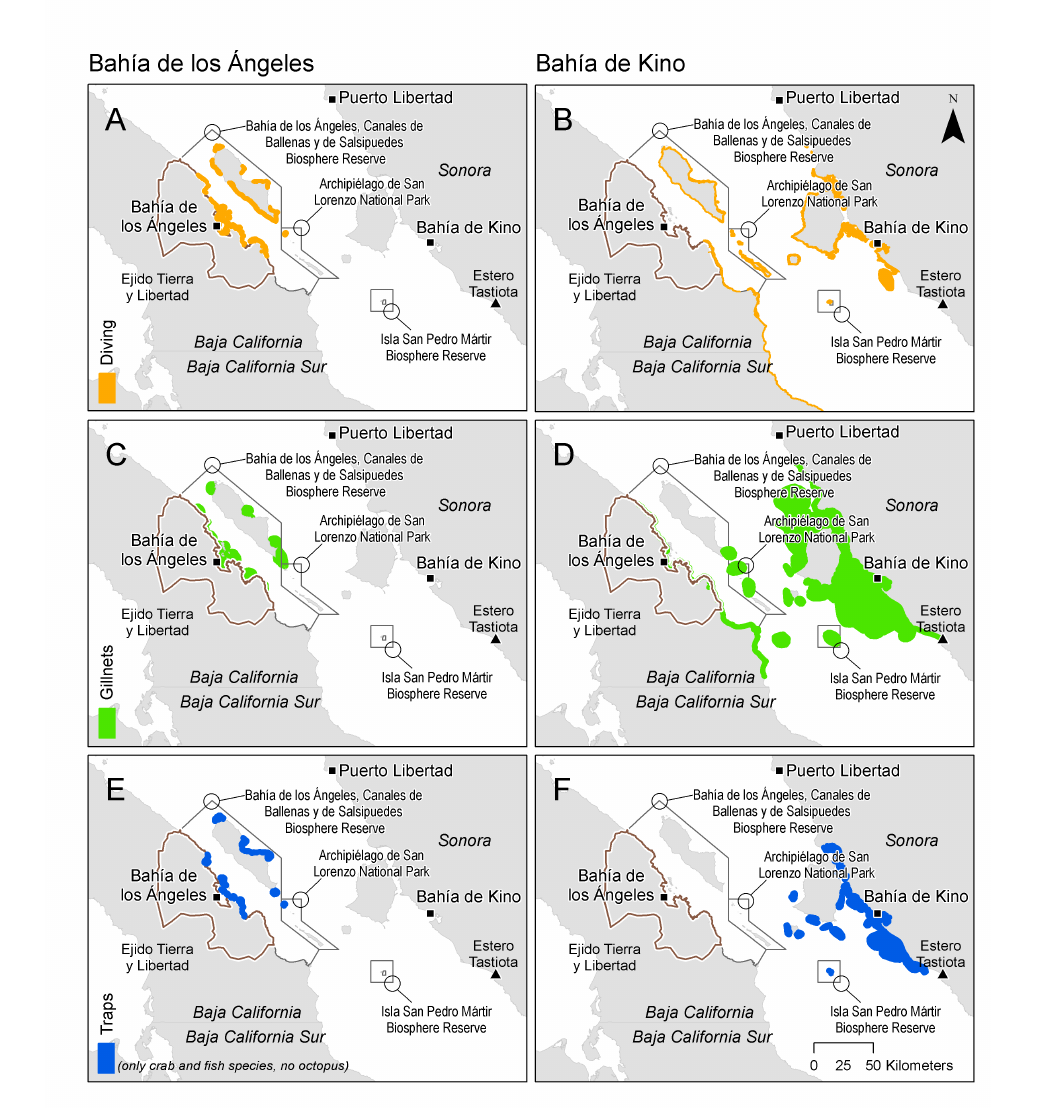
Fig. 2 . Fishing zones by community and gear. Source: rapid appraisal conducted in 2005–2006, Project PANGAS (Moreno-Báez